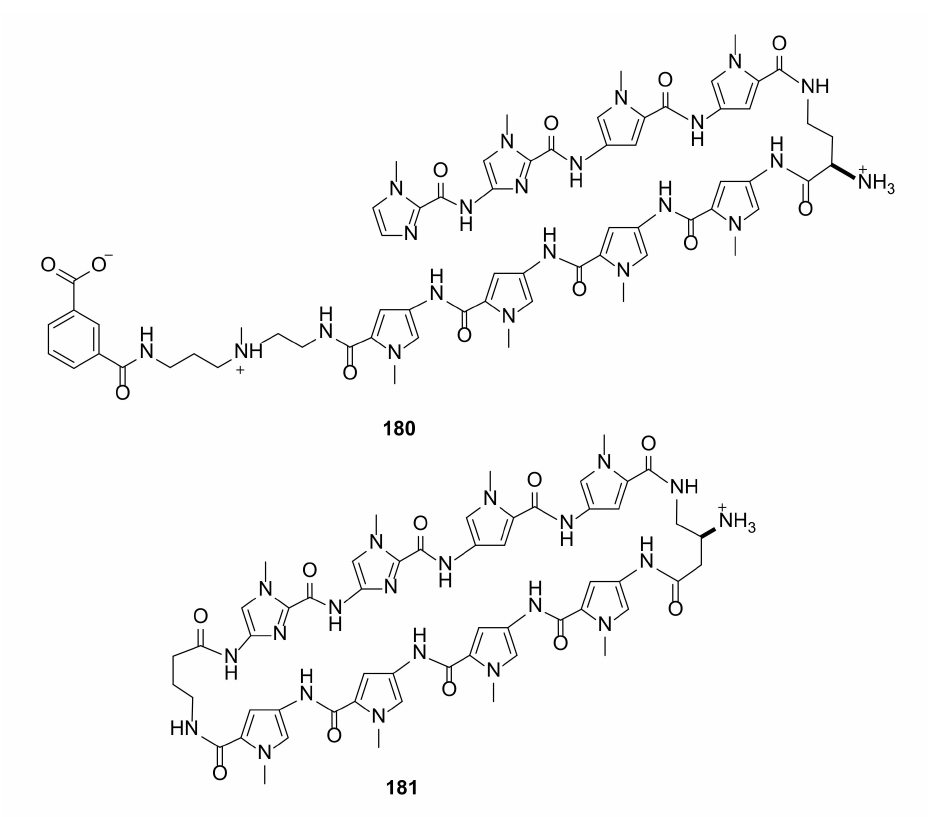
Figure 37. Structures of oligomeric ( 180 ) and macrocyclic ( 181 ) pyrrole–imidazole polyamides of a similar size studied in